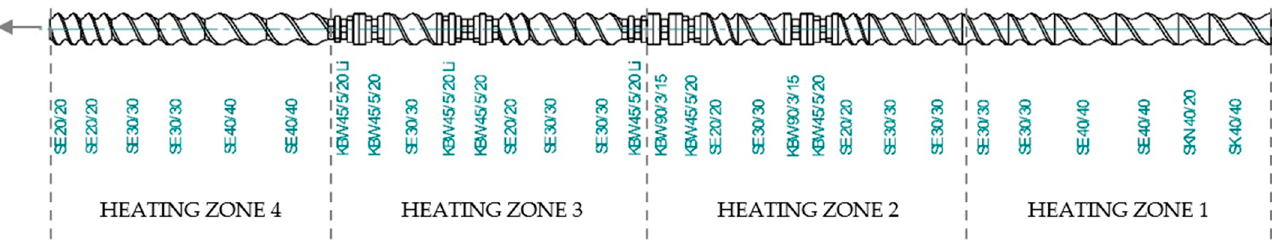
Figure 2. Screw configuration of the co-rotating, twin-screw extruder, where SK—feeding element, SE—conveying element, KBW—kneading block, and Li element—backward element. The numbers encode the angle (KBW only), step, and element length, in mm.